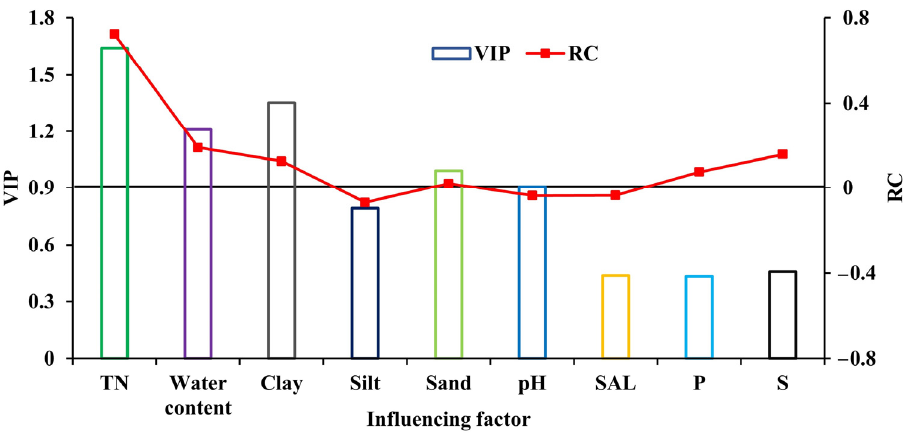
Figure 8. PLSR model of factors influencing soil OC content in natural coastal areas.